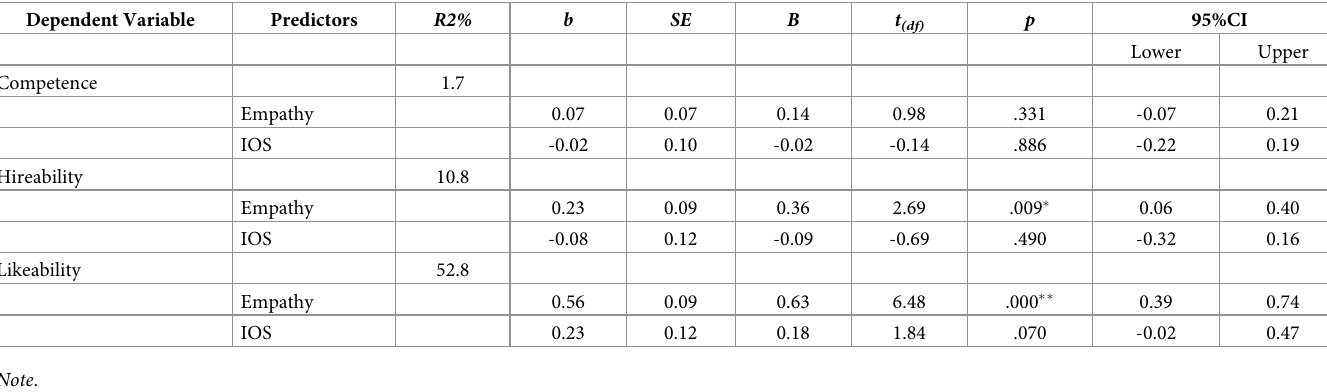
Table 5. Multiple regression models for the female